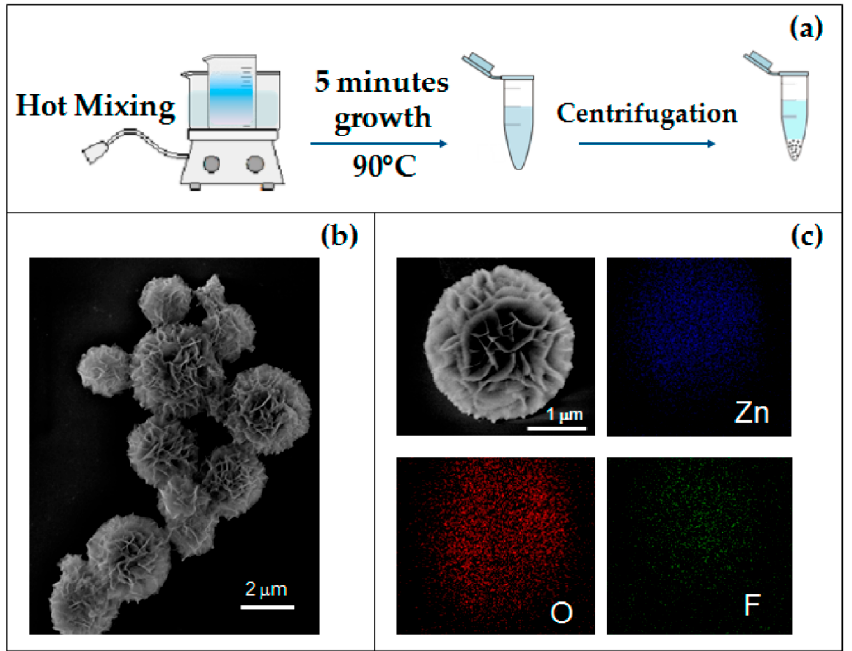
Figure 3. ( a ) Schematic synthesis diagram of the 3D flower-like hierarchical ZnO microstructures; ( b ) SEM image of as-grown MFs; ( c ) SEM image of a single MF and corresponding EDX elemental maps. Adapted from [56].